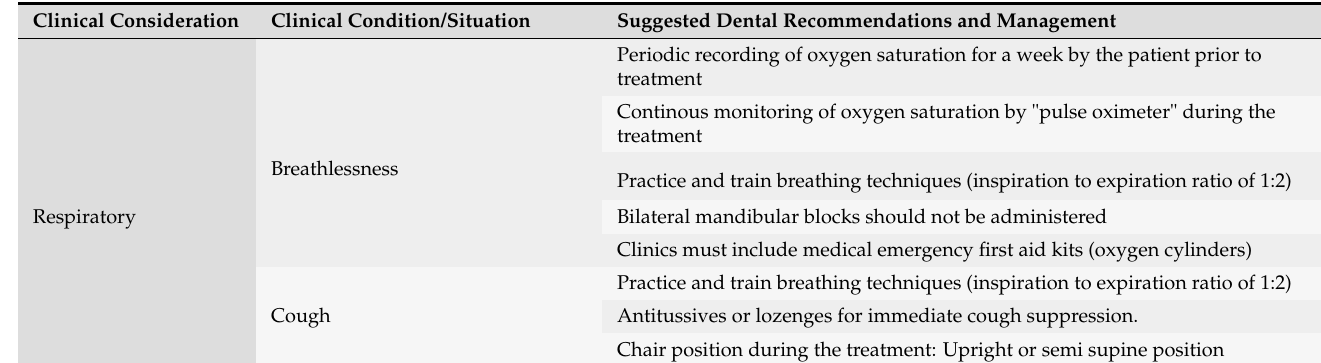
Table 4. Clinical considerations of post-COVID-19 patients and suggested dental